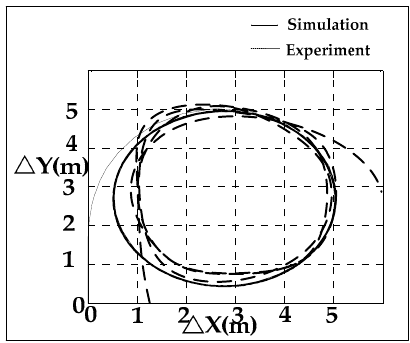
Figure 7 . +35 deg turning test: comparisons between simulated and experimental data.